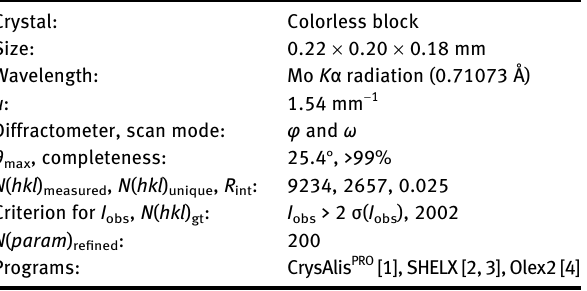
Table  : Data collection and handling.